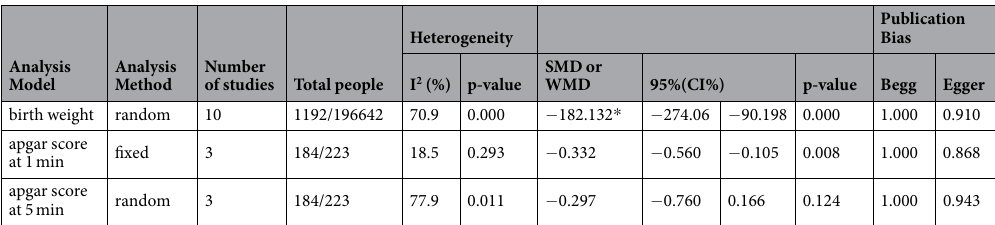
Table 3. Meta-analysis for general neonate outcome between isolated SUA and normal umbilical artery. * Indicates WMD.